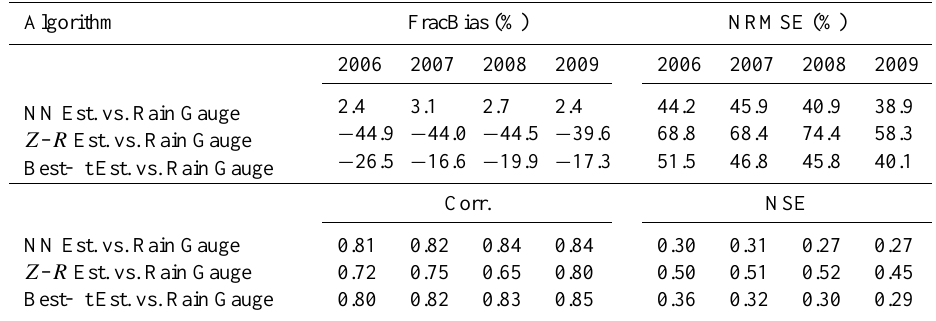
Table 1. Performance evaluation of the NN rain rate estimation, the Z – R estimation, and the best-fit estimation against rain gauge. Data from year 2006 to 2009 over KMLB. (Hourly rainfall accumulation).